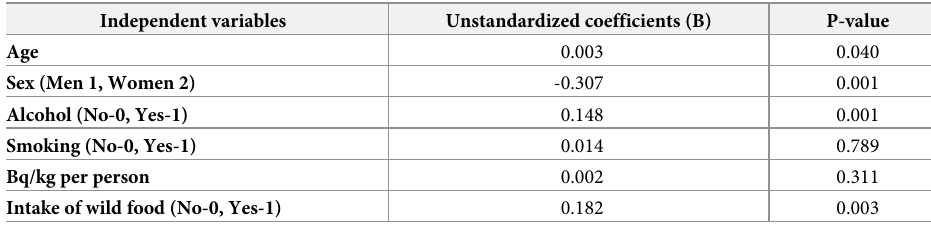
Table 3. Multiple regression analysis �